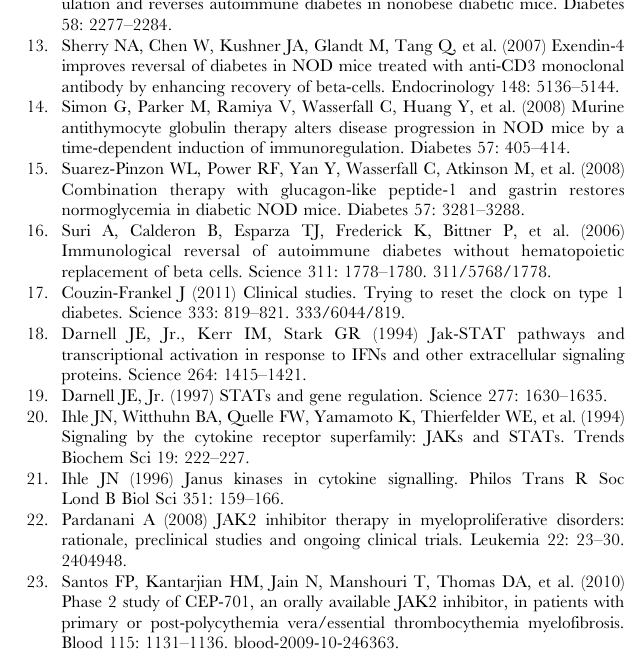
Table S1 AG490 reverses diabetes in NOD mice. Reversal of diabetes was performed by administration of AG490 via i.p route. Recently diagnosed diabetic NOD mice (n= 23) were under AG490 treatment for a period of 21 weeks. The age of disease onset, blood glucose level at disease onset and the mean of blood glucose level after treatment and also total number of AG490 injections are shown. Bold cases represent NOD mouse in which AG490 was effective and successfully established euglyce- mia (n= 7). *= Represents the mean of the blood glucose level and standard deviation of the mean in NOD mice from two weeks post diabetes onset till the end of the therapy is shown (week 21). Table S2 The mouse immune response genes to AG490 treatment. Female NOD mice were treated with AG490 or DMSO 3x/week for 5 consecutive weeks and then they were sacrificed one week after the last injection at week 10. Total RNA of purified CD4 + T-cells of splenocytes of treated mice and controls were pooled together and then subjected to real-time RT PCR using the mouse immune response genes array (Applied Biosystems) following manufacturer’s instructions. Data analyzing was performed using integrated software based on expression of two housekeeping genes and then calibrated based on the control mice (DMSO treated mice). Shown represents fold change gene expression in AG490 treated NOD mice when compared with the sham treated